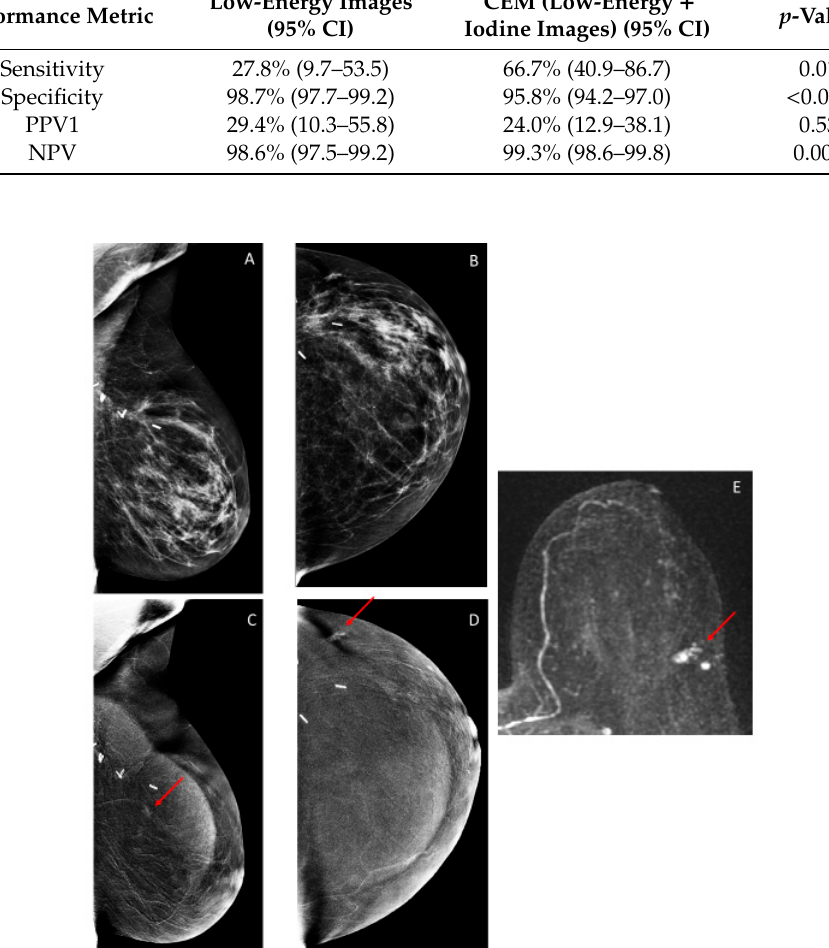
Figure 3. Sixty-six-year-old woman treated with left breast conservation 3 years prior for invasive ductal carcinoma (IDC) and ductal carcinoma in situ (DCIS). ( A , B ) Low-energy images show postsurgical distortion but no suspicious findings. ( C , D ) Iodine images show clumped non-mass enhancement in the outer central breast (arrows). Targeted ultrasound showed no correlative finding. MRI shows non-mass enhancement spanning 1.3 cm (( E ) left breast subtraction maximum intensity projection (MIP)); the enhancement was biopsied with MRI guidance, yielding IDC and DCIS. The patient was then treated with a